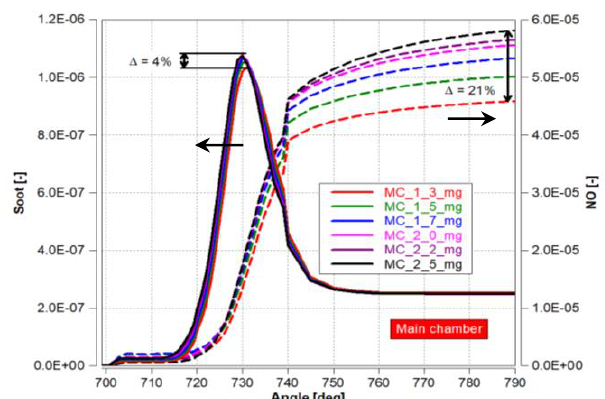
Fig. 17. Changes in NO and soot mass fraction in the main chamber at different fuel dose values qo_PC